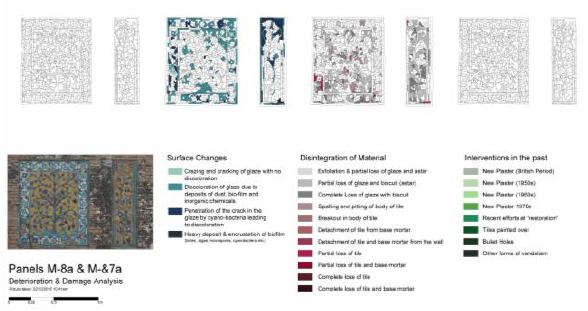
Figure 6. Damage Analysis of Panels